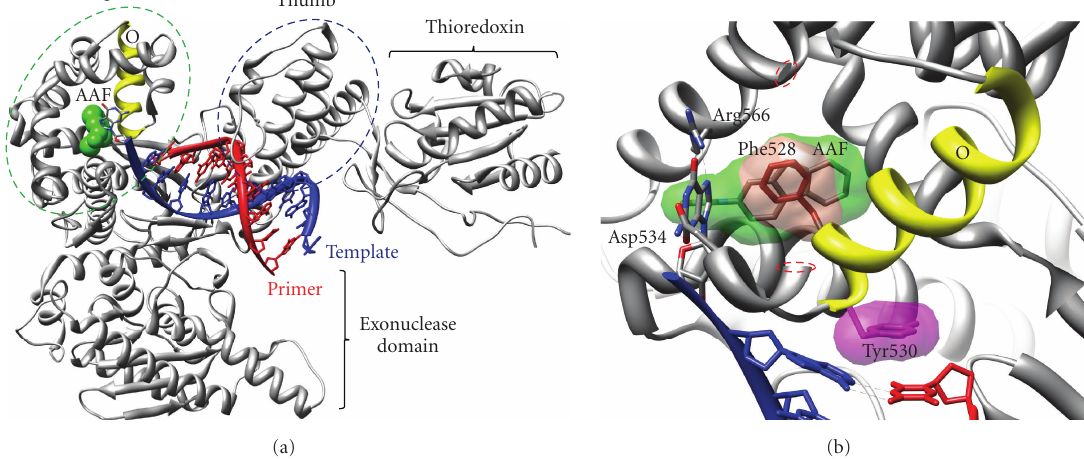
Figure 4: Structure of bacteriophage T7 polymerase bound to a DNA primer-template containing a dG-AAF adduct at the templating position (PDB# 1X9M) [32]. (a) The overall shape of T7 polymerase resembles a human right hand forming fingers (green circle), thumb (blue circle), and palm (not highlighted). T7 also contains thioredoxin, a processivity factory, in addition to the polymerase and exonuclease domains. The AAF adduct (green) inserts behind the O helix (yellow), locking the helix in a distorted open conformation, inhibiting the binding of dNTPs. (b) Close-up view of active site. The AAF moiety (grey with green space filling) is inserted into a hydrophobic pocket behind the O helix stacking with a flipped out Phe528 (brown, with brown space filling), which is buried in the native structure. The adducted guanine is in an anti conformation placing the hydrogen bond acceptors and donors away from the nucleotide binding position. This position is further stabilized by hydrogen bonds to Arg566 and Asp534. The AAF moiety pushes the O helix forward, causing Tyr530 (pink with pink space filling) to stack on top of the DNA, occupying the nucleotide binding site which occludes a dNTP from binding. Residues 537–557 have been removed for simplified visualization (ends are circled